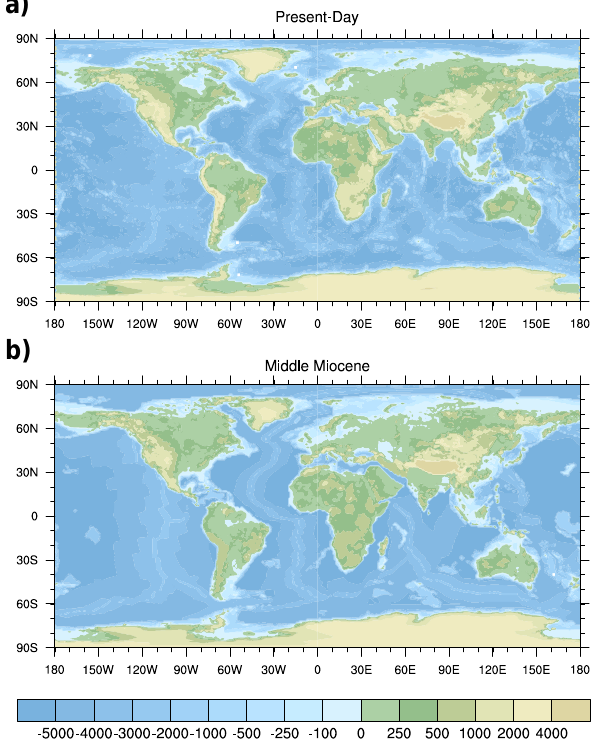
Fig. 1. (a) The present-day topography we use in CTRL, and (b) the Middle Miocene topography we use in MIOC360, MIOC480, and MIOC720 (in